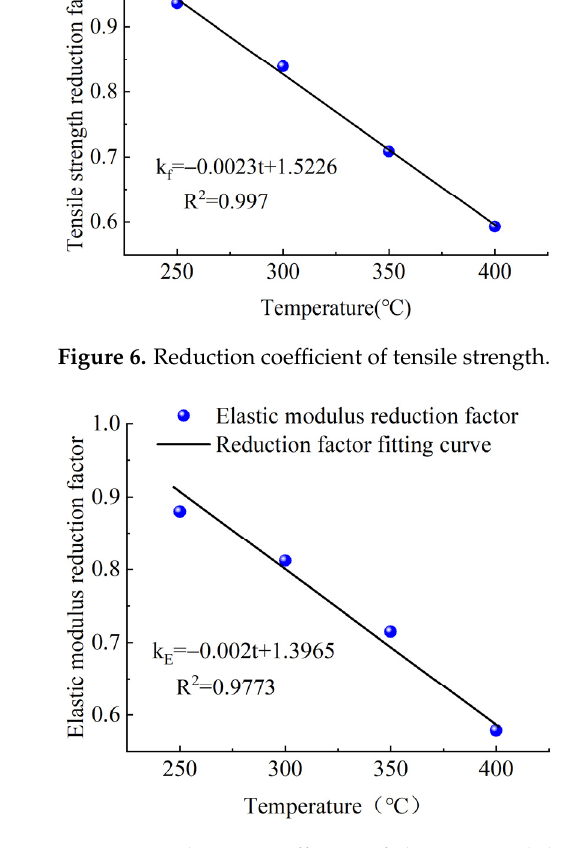
Figure 7. Reduction coefficient of elasticity modulus.